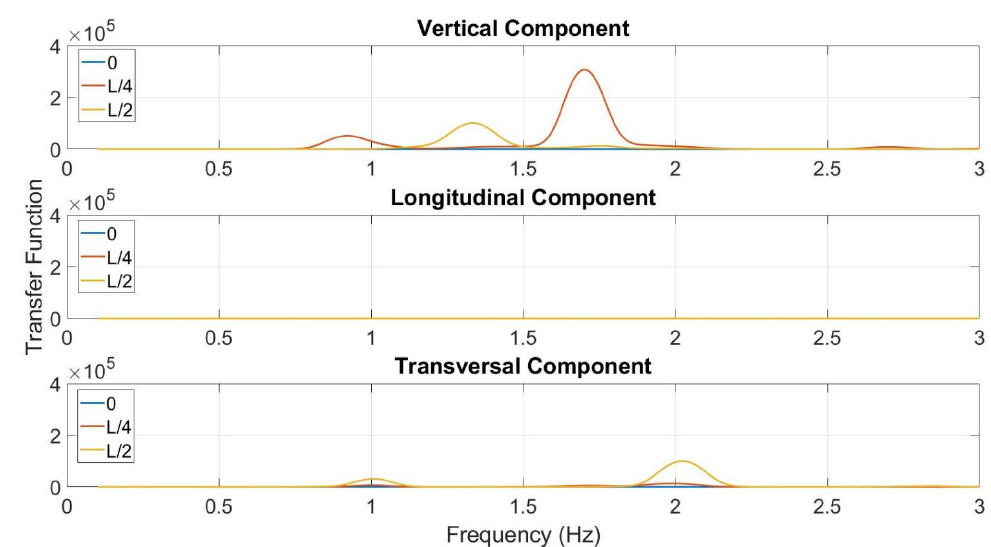
Figure 13. Transfer functions of the monitored bridge.